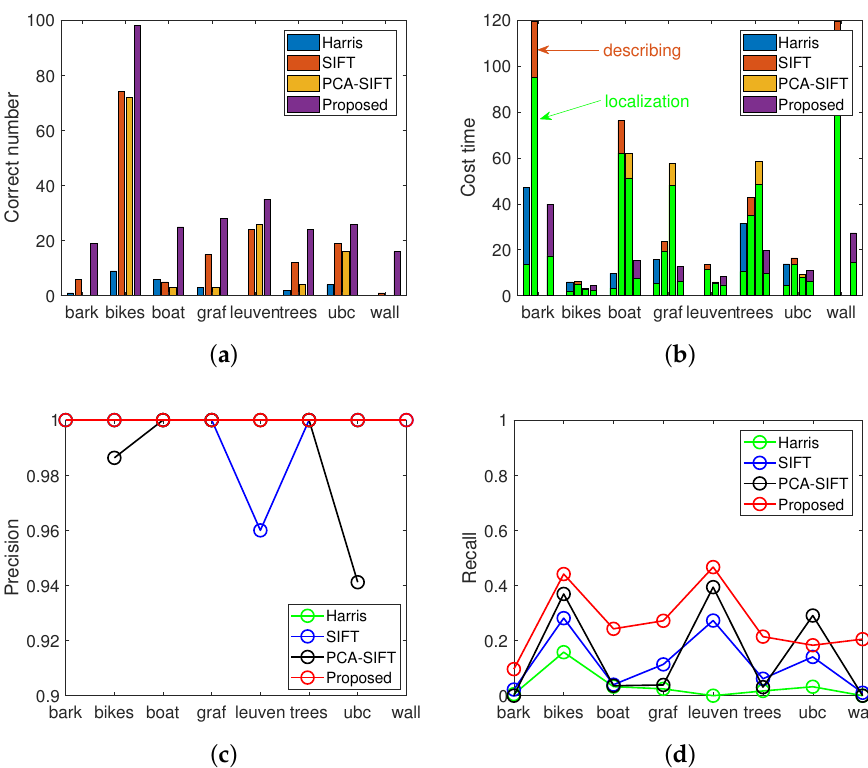
Figure 15. Results analysis of matching test on Oxford database: ( a ) correct matching number; ( b ) cost time per match; ( c ) precision of the matches; ( d ) recall of the